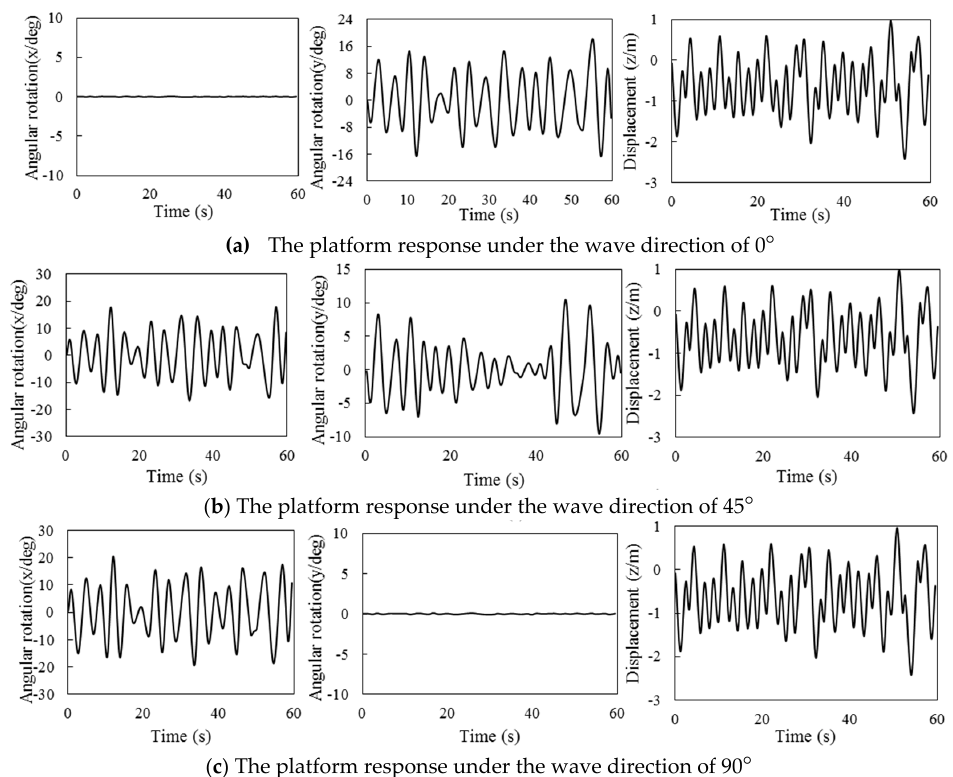
Figure 6. The platform response under wind − sea scale 4 with different wave directions.